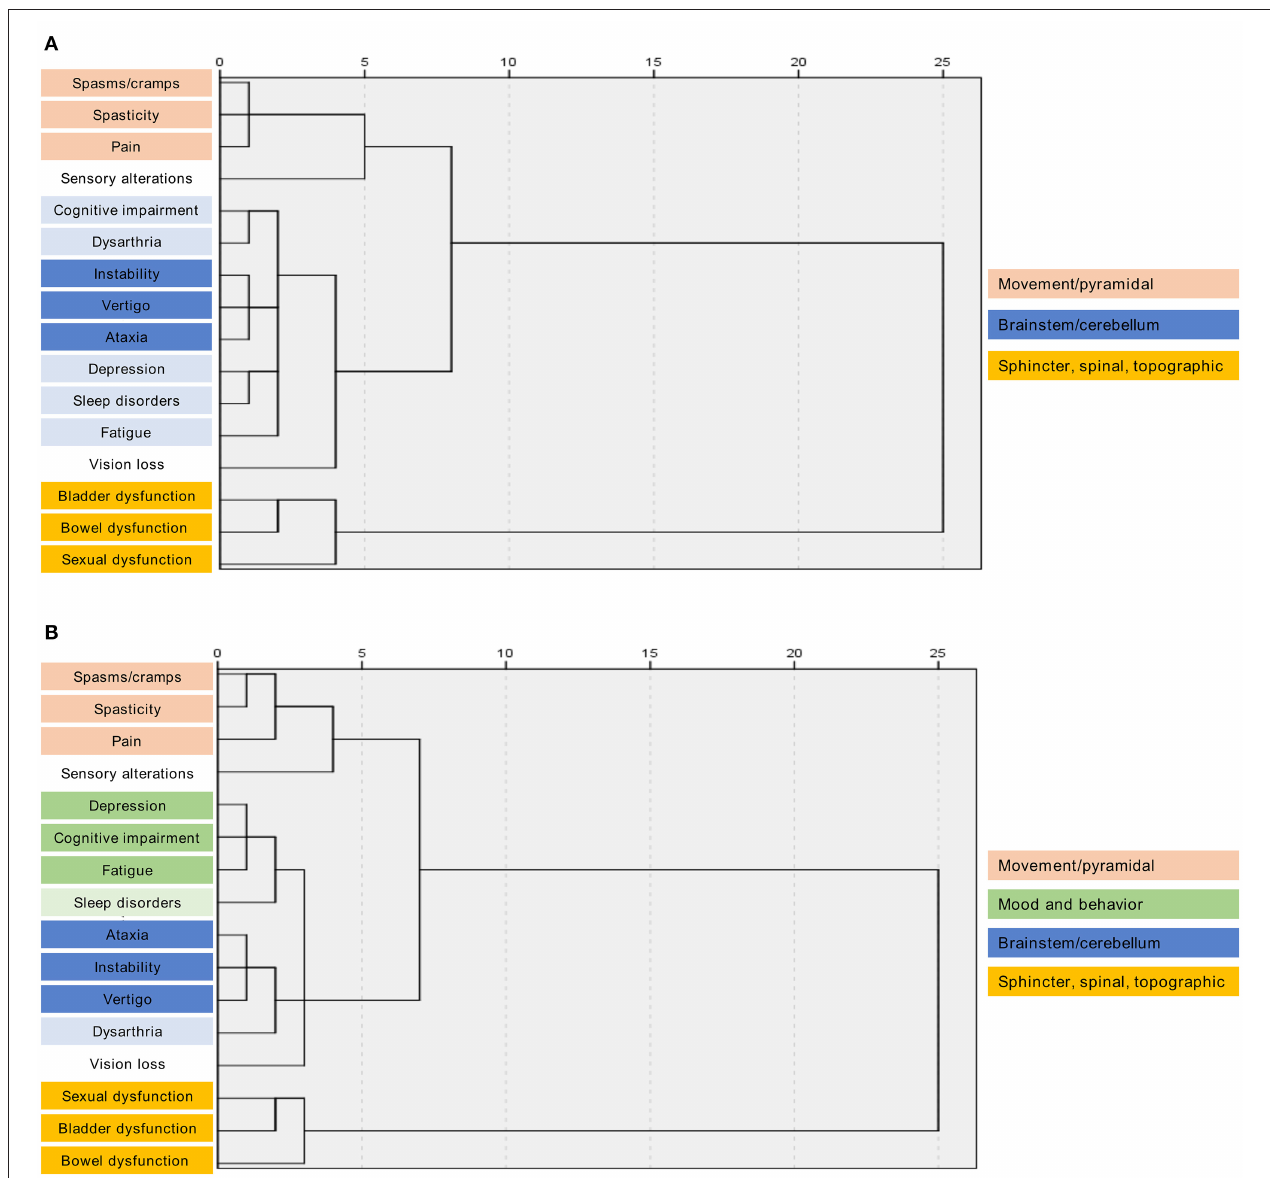
FIGURE 1 | Hierarchical clustering of multiple sclerosis symptoms by joint onset or common pathophysiology. Dendrograms show symptom clusters by (A) joint onset or (B) common pathophysiology. The x-axis represents the distance between nodes. Symptoms were clustered using Ward’s method. of spasticity was 7.82 points, while sensory alterations showed the lowest score (5.49) ( Figure 2